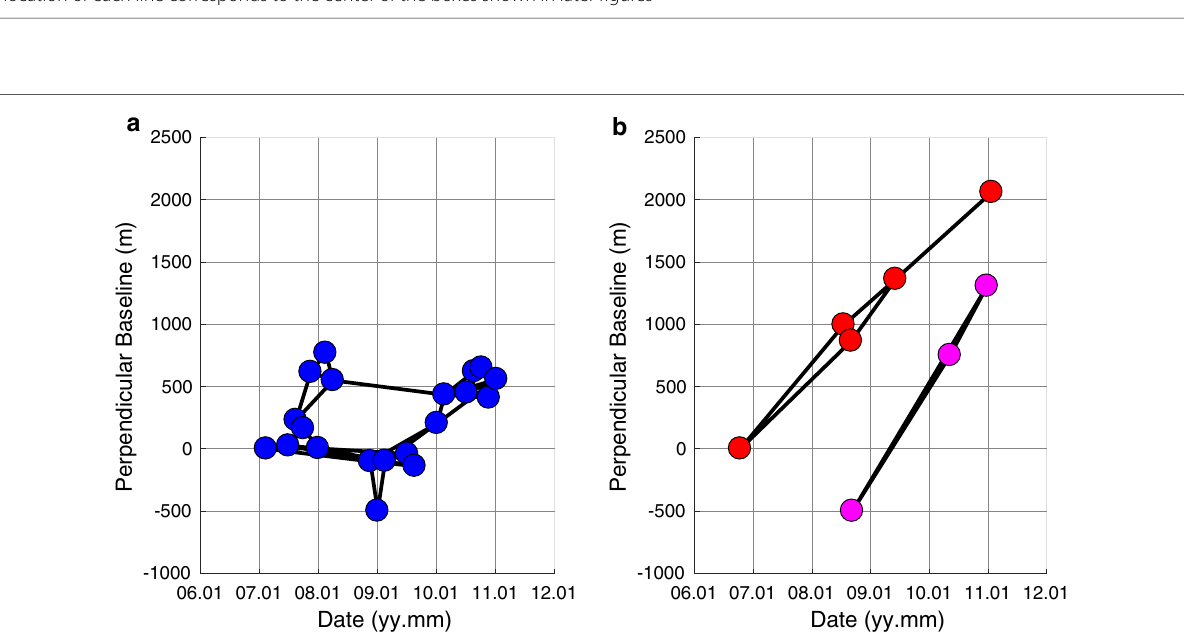
Fig. 4 Acquisition dates and perpendicular baselines of the PALSAR data used in the InSAR time-series analyses. a Ascending dataset (Path 443), b descending datasets (magenta for Path 77 and red for Path